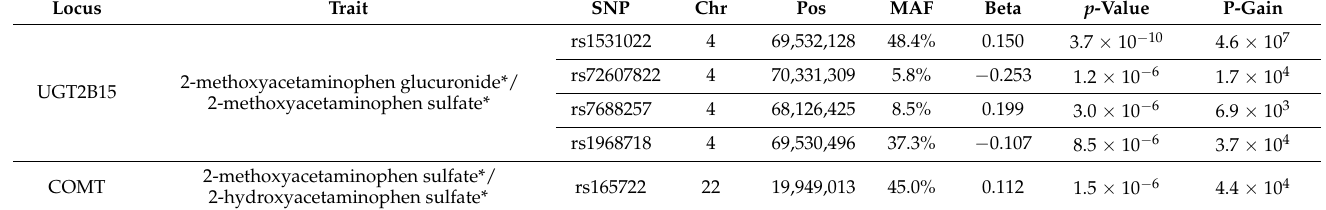
Table 2. Summary statistics for the associations at the UGT2B15 and COMT loci.